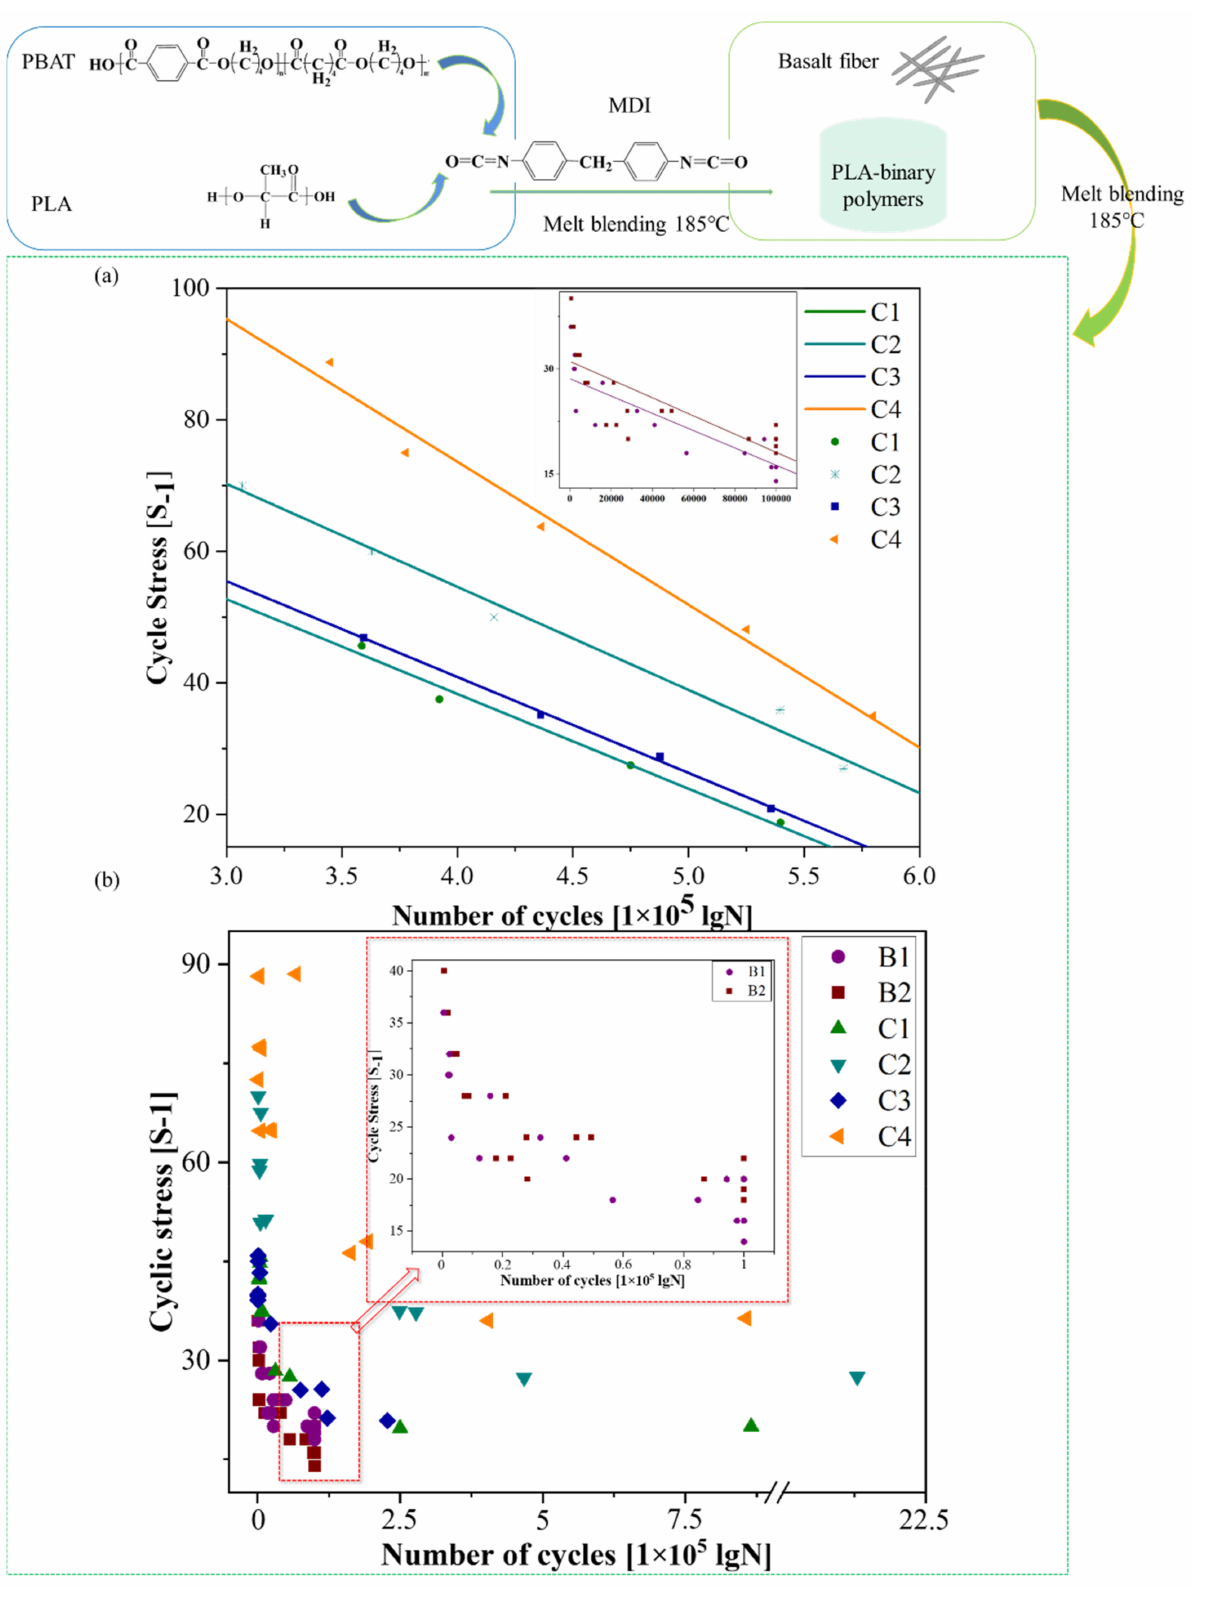
Figure 7. The mechanical properties of the PLA-based binary and ternary blends with a focus on the tension–tension fatigue properties: ( a ) S – N curves and ( b ) fatigue